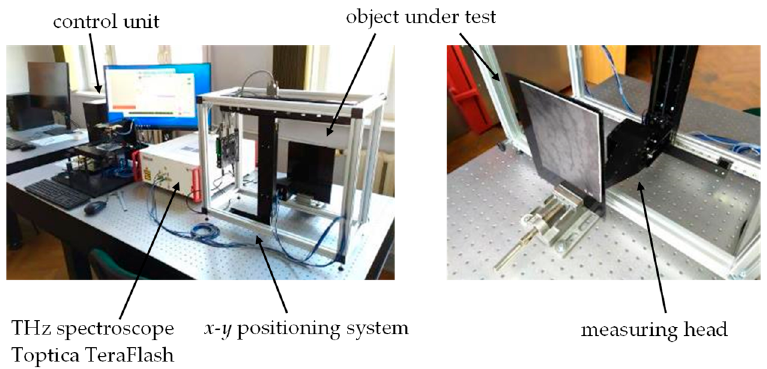
Figure 6. View of terahertz imaging system.